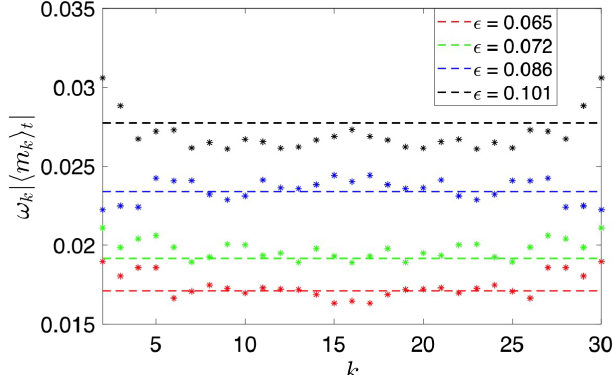
as a function of the tot